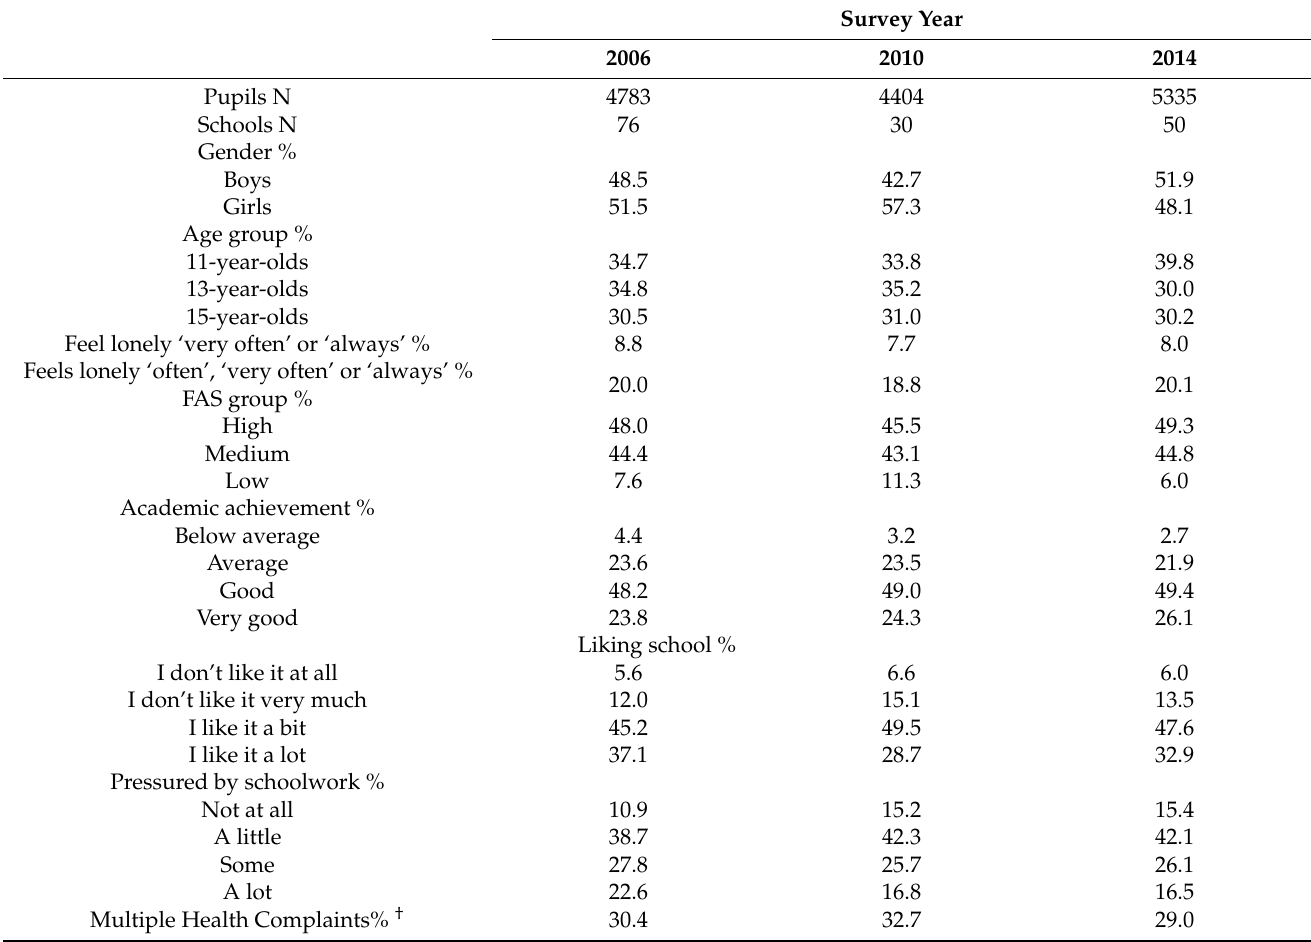
Table 1. The study population by survey year and gender, age group, prevalence of loneliness, and family